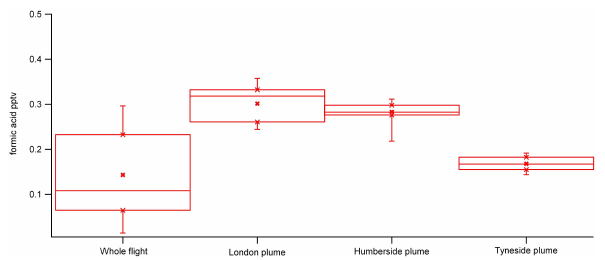
Fig. 7. Box and whisker plots of total flight data and individual plumes detected during flight B518. Whiskers indicate the 5th and 95th percentile.